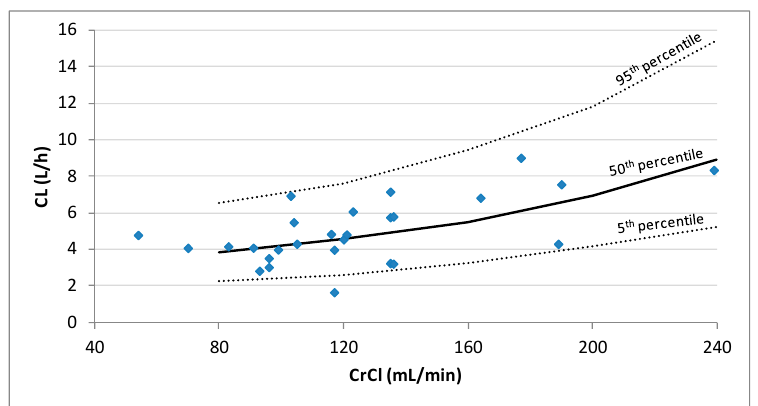
Figure 4. Plot of the individual predicted levetiracetam clearances (CL) estimated by population PK analysis vs. creatinine clearance (CrCl) for the 27 patients. Lines represent the 5th, 50th, and 95th percentiles of 1000 simulations performed at CrCl values of 80, 160, 200, and 240 mL/min.